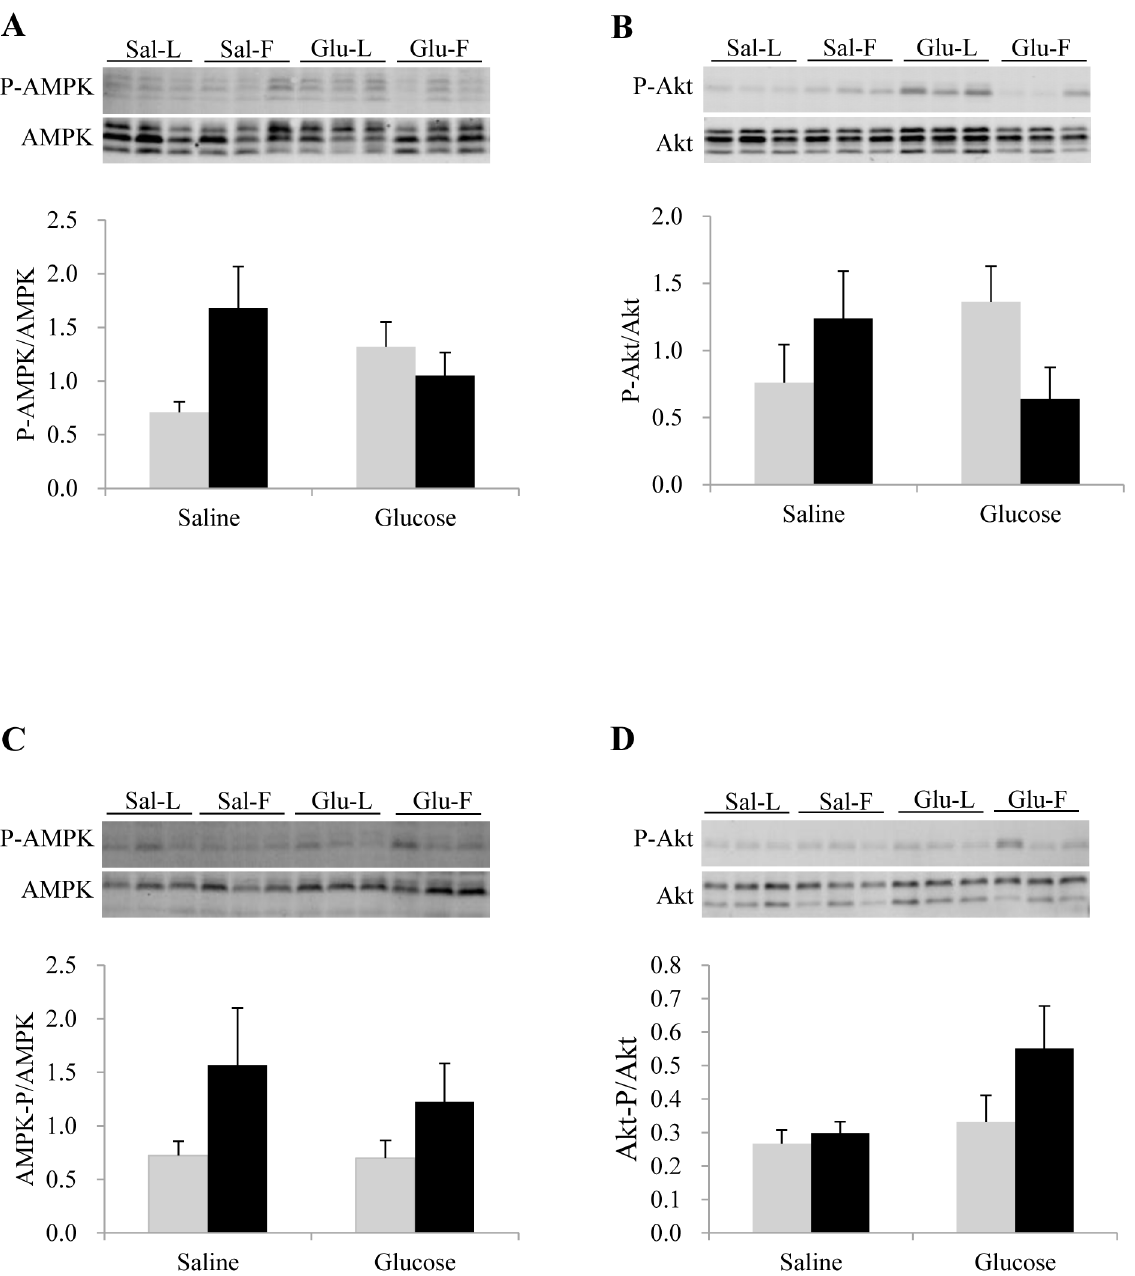
Figure 2. Western blot analysis of AMPK and Akt phosphorylation in rainbow trout liver (A) and muscle (B) samples from L line (L; grey bars) and F line (F; black bars), 3 h after IP administration of glucose or saline solution. 10 and 20 m g of total protein per lane for Akt and AMPK were loaded on the gel respectively. Western blots were performed on 6 individual samples per treatment and a representative blot is shown here. Data were analyzed using two-way ANOVA (P , 0.05), followed by a Student-Newman-Keuls multiple comparison